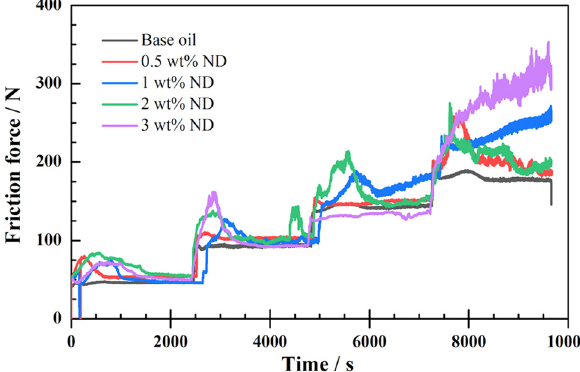
Figure 4: Variation of friction force between the BP liner and the CrN - coated piston